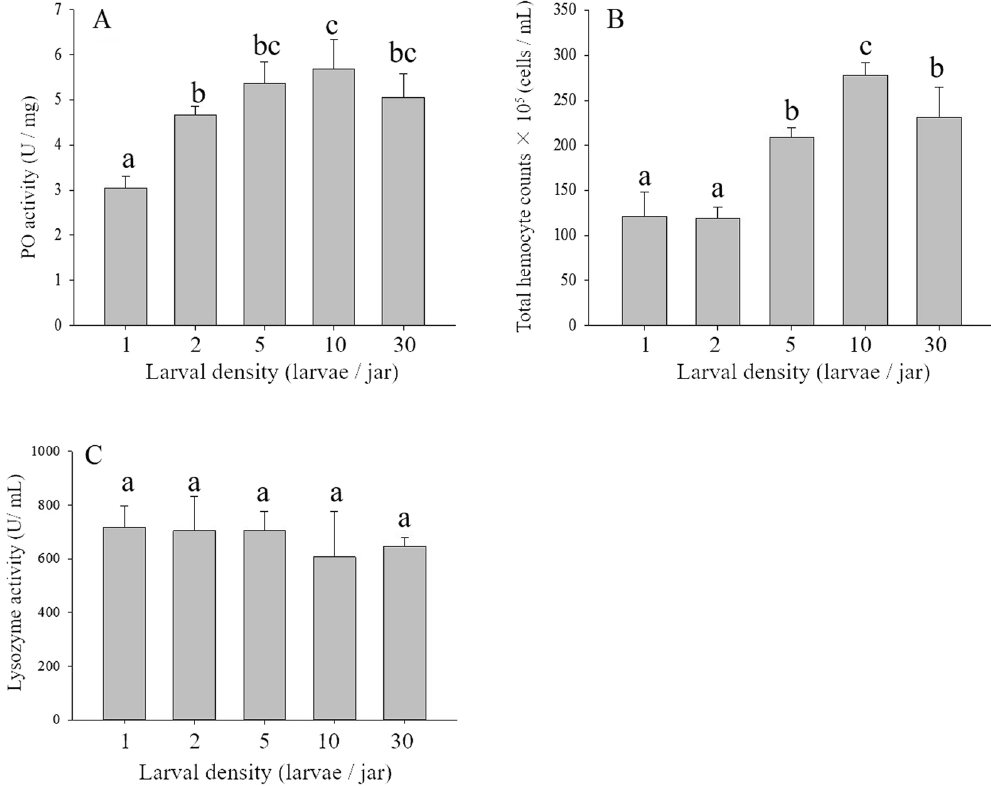
Figure 1. Effect of larval density on three measures of larval immune function in M . separata . ( A ) Phenoloxidase activity. ( B ) Total haemocyte count. ( C ) Lysozyme activity. Values are means ± SE. Different letters indicate significant differences among the densities of 1, 2, 5, 10 and 30 larvae/jar (P <